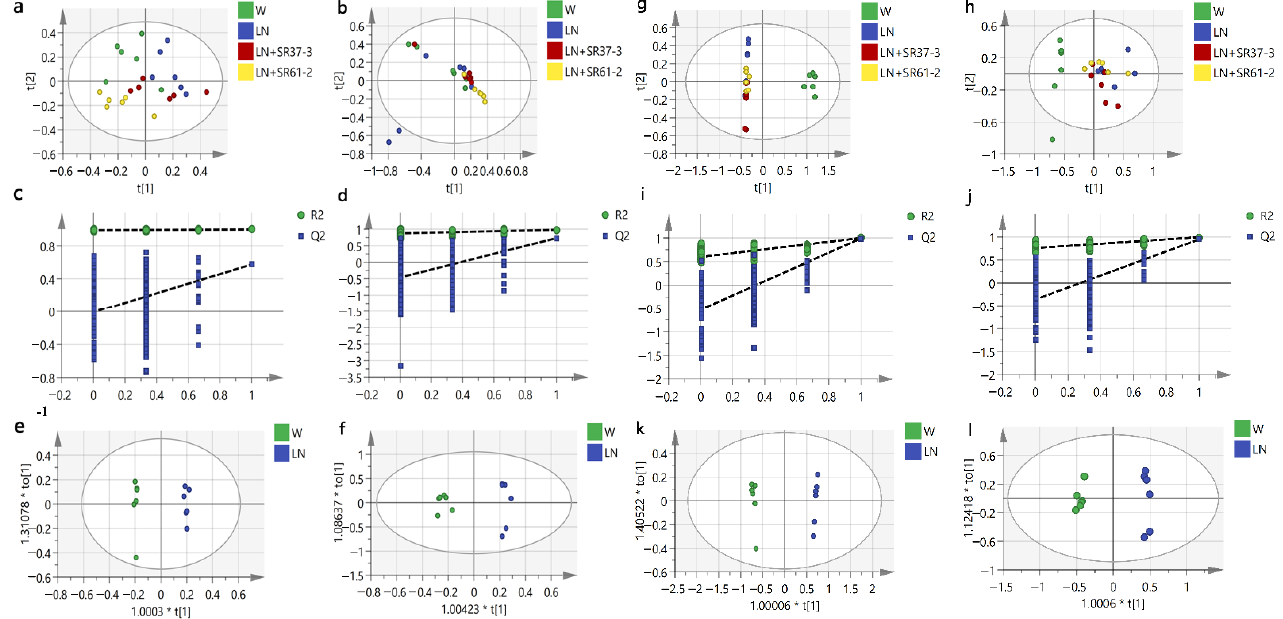
Figure 4. The analysis of the LC ‐ MS of serum samples of hypertensive rats ( a – f ). The distribution of the PCA score plots for the W, LN, LN + SR37 ‐ 3 and SR61 ‐ 2 groups in the positive model ( a ) and negative model ( b ). Permutation test charts for the OPLS ‐ DA model between W and LN of the metabolomics data set in the positive (R 2 = (0, 0.989); Q 2 = (0, − 0.00648)) model ( c ) and the negative (R 2 = (0, 0.876); Q 2 = (0, − 0.458)) model ( d ). The OPLS ‐ DA score plot of the metabolomics data set in the positive (R 2 Y = 0.997; Q 2 Y = 0.575) model ( e ) and negative (R 2 Y = 0.981; Q 2 Y = 0.732) model ( f ). The analysis of the LC ‐ MS of cecal contents samples of hypertensive rats ( g – l ). The PCA score plots distribution for the W, LN, LN + SR37 ‐ 3 and SR61 ‐ 2 group in the positive model ( g ) and negative model ( h ). Permutation test charts for the OPLS ‐ DA model between the W and LN of the metabolomics data set in the positive (R 2 = (0, 0.597); Q 2 = (0, − 0.52)) model ( i ) and negative (R 2 = (0, 0.759); Q 2 = (0, − 0.355)) model ( j ). The OPLS ‐ DA score plot of the metabolomics data set in the positive (R 2 Y = 0.997; Q 2 Y = 0.99) model ( k ) and negative (R 2 Y = 0.994; Q 2 Y = 0.945) model ( l ). cont W: animals not treated with L ‐ NAME receiving standard chow; cont LN: L ‐ NAME ‐ treated rats receiving standard chow; LN + SR37 ‐ 3: L ‐ NAME ‐ treated rats receiving PFM ‐ SR37 ‐ 3; and LN + SR61 ‐ 2: L ‐ NAME treated rats receiving PFM ‐ SR61 ‐ 2. t[1] is the weight of the regression coefficient for the predicted principal component (abscissa). The data next to “*” represents the weight value. “*” Not practical.